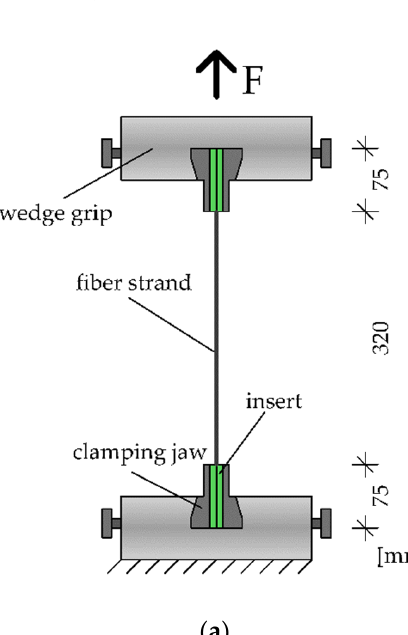
Figure 11. Test setup for testing the tensile strength of fiber strands, a) drawing, b) in the labora- tory